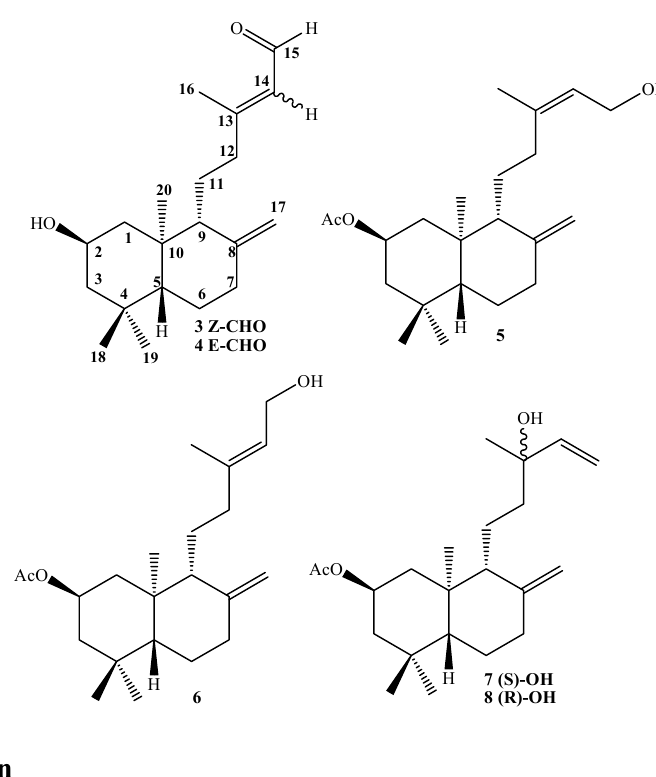
Figure 2. Structure of natural ent-labdanes and